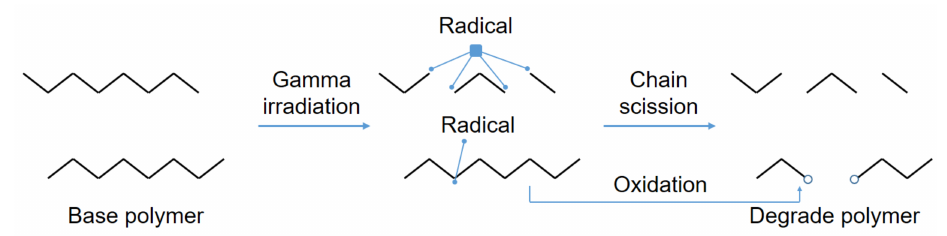
Figure 5. Schematic diagram of chain scission reaction according to gamma irradiation.